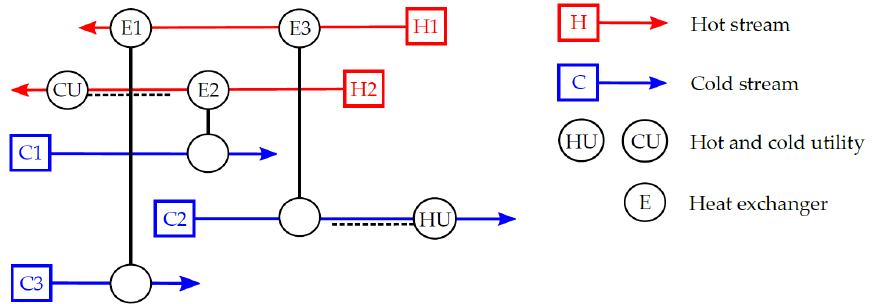
Figure 2. Heat Exchanger Network (HEN) not containing a Utility Path.